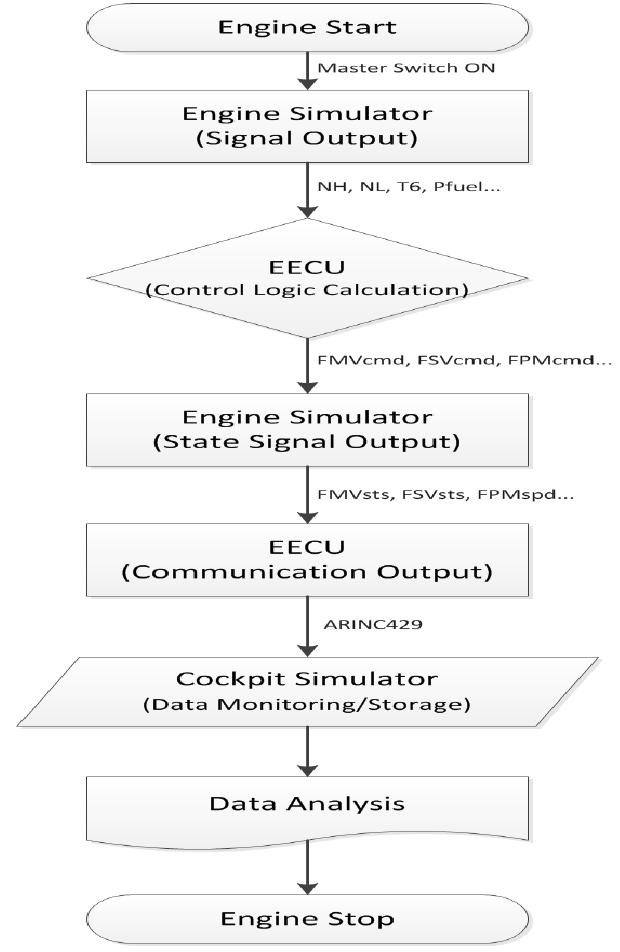
Figure 12. Process of control logic performance test.